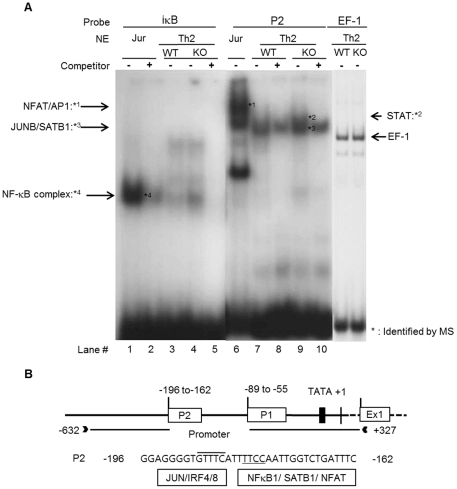
Identification and analysis of IL-4 promoter-binding transcription factors.EMSA assay was carried out with nuclear extracts prepared from Th2 cells of WT and NFAT1 KO or from Jurkat cells that were stimulated with anti-CD3 for 6 h or PMA/I for 2 h, respectively (A). 32P-labelled P2 probes were incubated with indicated nuclear extracts. IκB probe containing κB element was used as a positive control and 100 pmol unlabeled iκB probe was used as a competitor to interfere the complex formation. (−) or (+) indicates in the absence or presence competitor, respectively. The DNA binding complexes that appeared or were enhanced after stimulation are indicated. Arrows indicate the identified proteins that bound to the corresponding gel band. Equal loading of nuclear extracts was controlled by using the binding site for the constitutive factor EF-1 as a probe. Identification of DNA-binding transcription factors was carried out by micro-LC/LC-MS/MS analysis as described in Material and Methods. (B) Predicted DNA binding elements for the P2 region of IL-4 promoter.